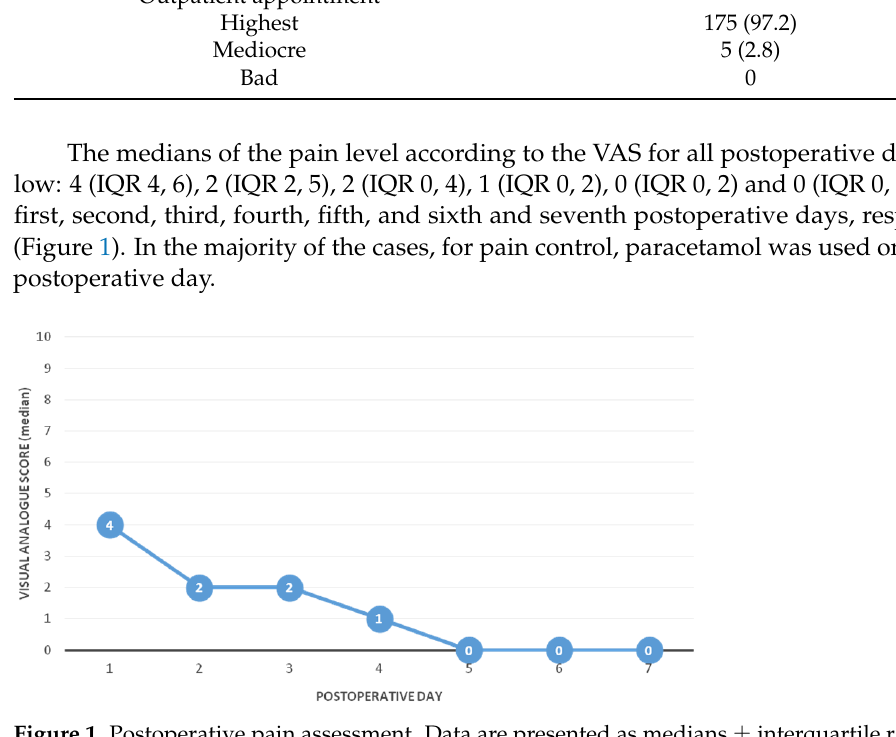
Figure 1. Postoperative pain assessment. Data are presented as medians ± interquartile ranges.